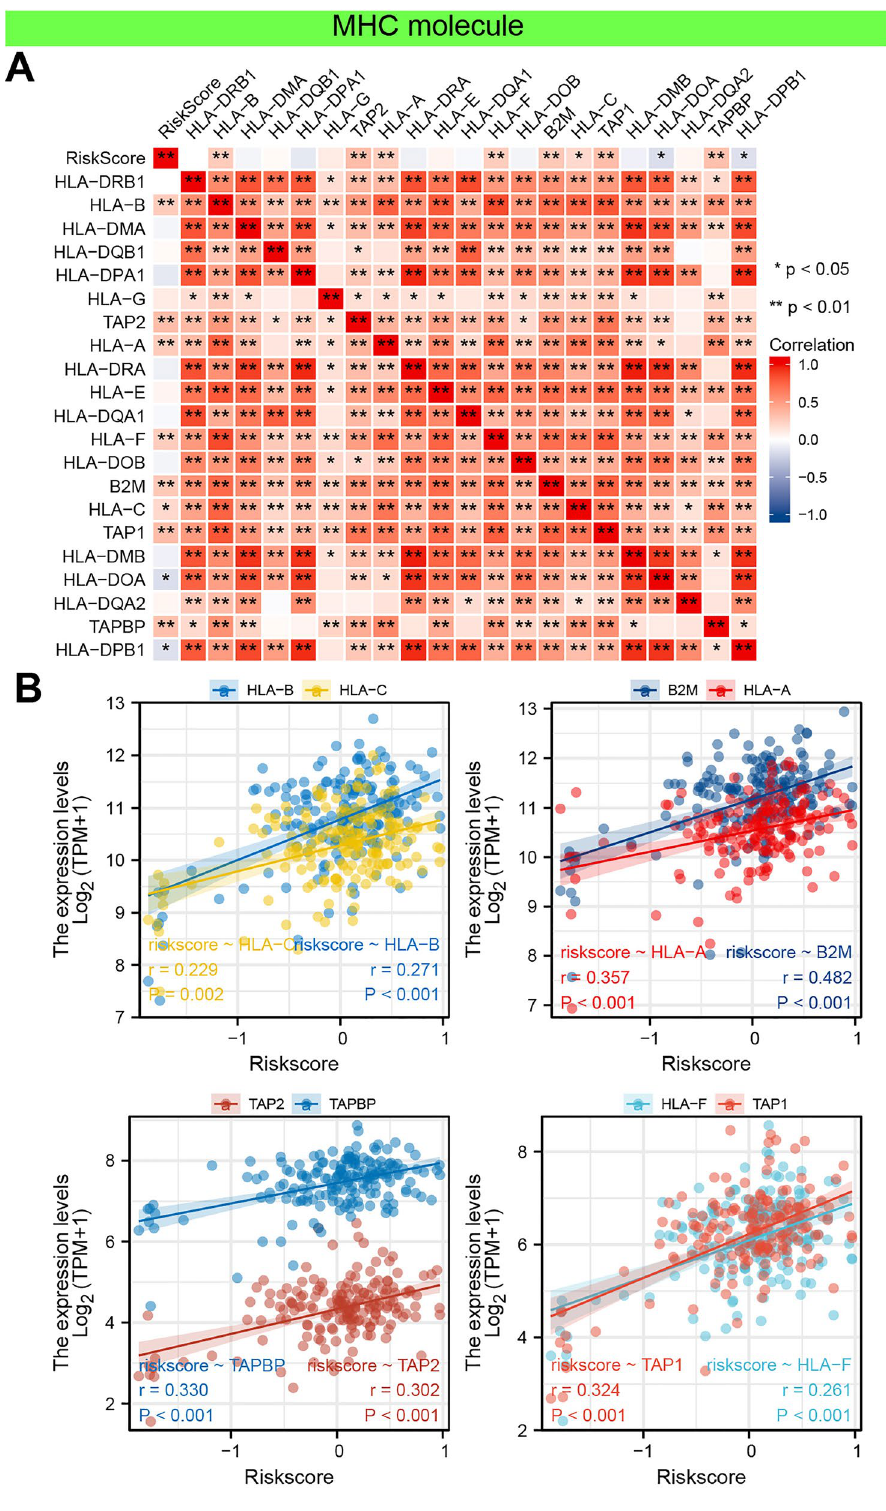
Figure 13. Analysis of correlation between PAAD-IRGS and MHC molecule. ( A ) MHC molecule genes— PAAD-IRGS heatmap; ( B ) correlation analysis of MHC molecule genes and PAAD-IRGS. MHC major histocompatibility complex; * P < 0.05, ** P < 0.01, *** P <